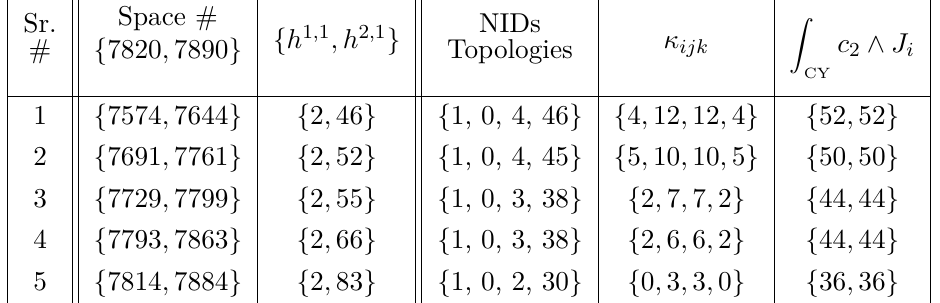
= 1 . Here, Table 4 . Number of favorable pCICYs for h 1 , 1 = 2 and having NIDs to give h 1 , 1 − the divisor topologies are represented with the Hodge numbers { h 0 , 0 , h 1 , 0 , h 2 , 0 , h 1 , 1 } . Also, the intersection section numbers κ are collected as { κ ijk 111 , κ 112 , κ 122 , κ 222 }